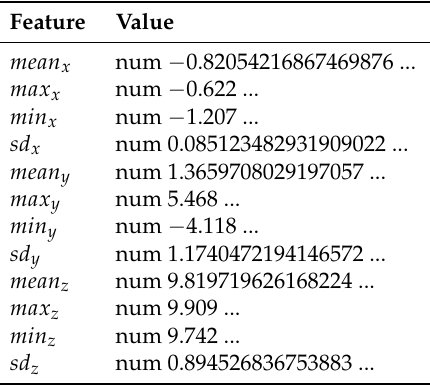
Table 4. An example of feature extraction.